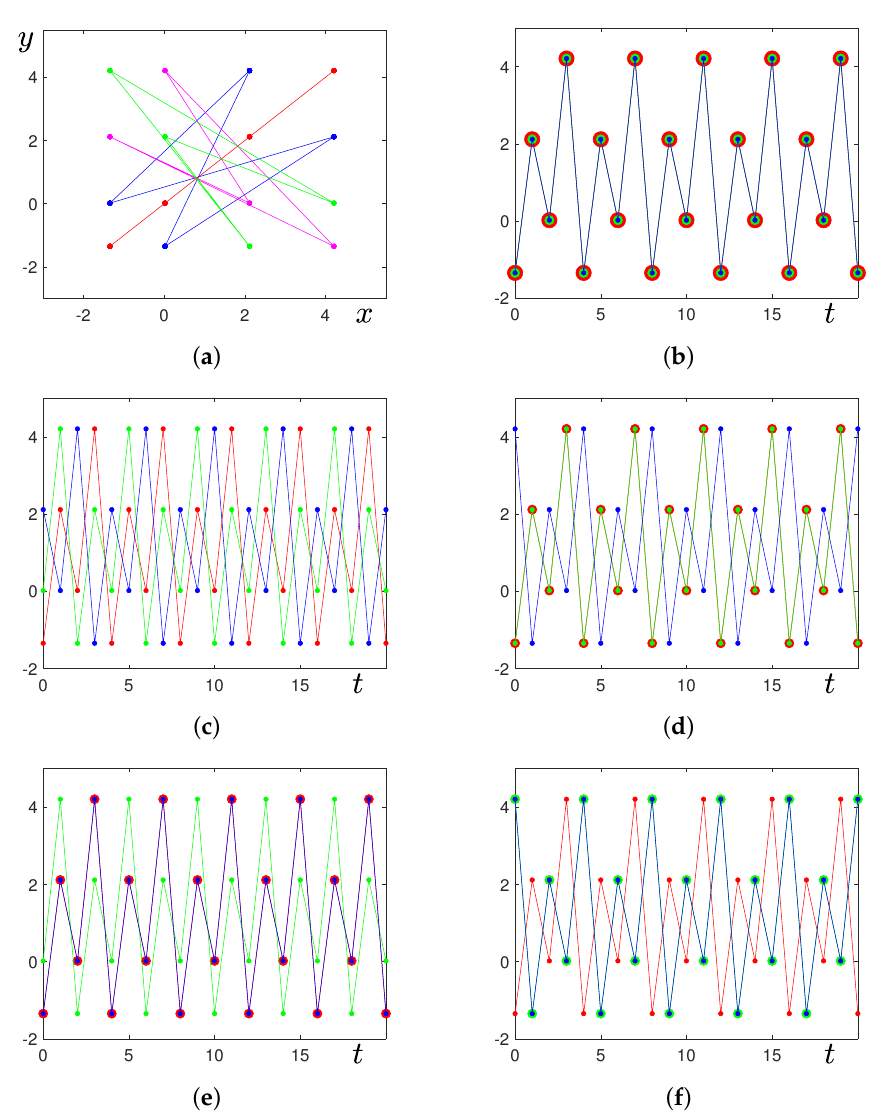
Figure 3. Coexisting 4-cycles in system (1) for σ = 0.4. ( a ) Projections of 16 coexisting 4-cycles on the ( x , y ) plane. Time series of ( b ) complete synchronization ([0003]-pattern) and mixed synchronization with ( c ) [0111]-pattern, ( d ) [1002]-pattern, ( e ) [0102]-pattern, and ( f )